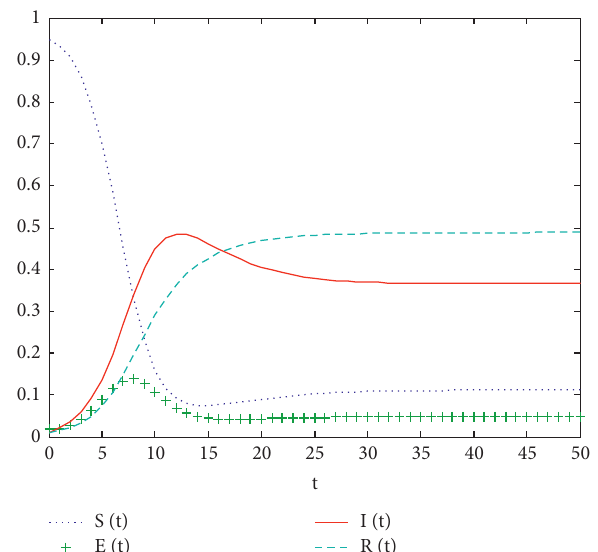
Figure 8: The population density curve of netizens in four categories at the initial